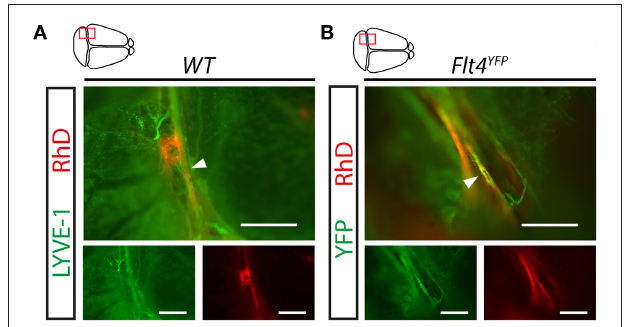
FIGURE 2 | Uptake and transport of fluorescently labeled macromolecules injected into the CNS by the meningeal lymphatic vessels. (A,B) Monitoring the uptake and transport of 70 kDa RhD by the meningeal lymphatic vessels shown in whole-mount stained meninges of young adult wild type mice using the LYVE-1 marker (A) and YFP signal in Flt4 YFP lymphatic reporter mice (B) imaged by fluorescent stereo microscopy after intraparenchymal injection with 70 kDa RhD. Representative images are shown of 3 independent experiments. White arrowheads show RhD in the meningeal lymphatic vessels. Bars, 500 µ